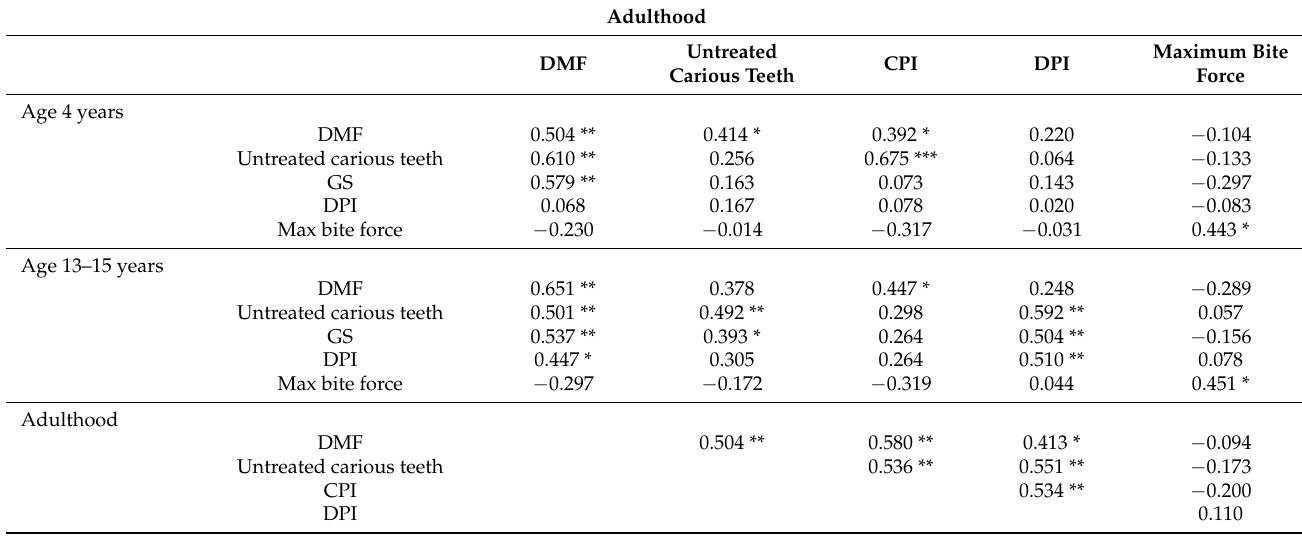
Table 5. Correlation among variables.